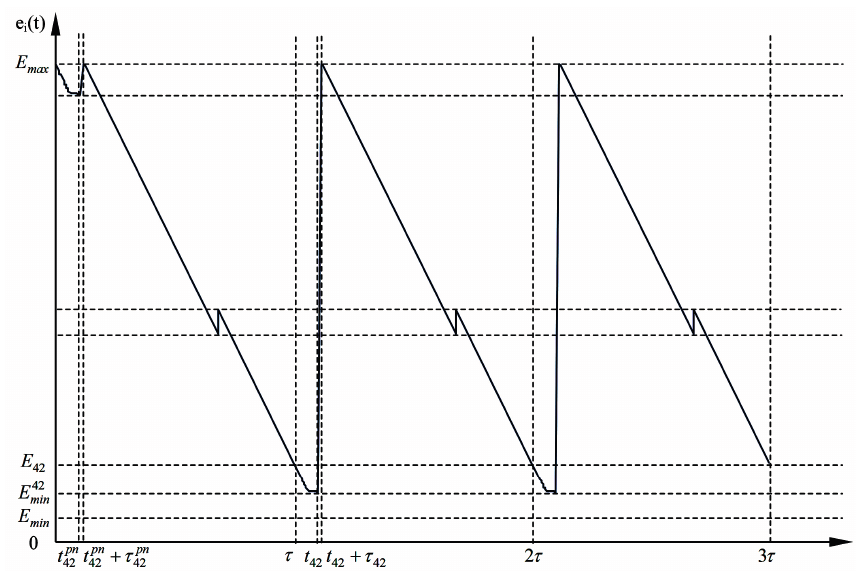
Figure 14. The energy-time curve of the 42nd sensor node with extra energy replenishing in the pre-normal replenishing stage and the 1st and 2nd normal replenishing